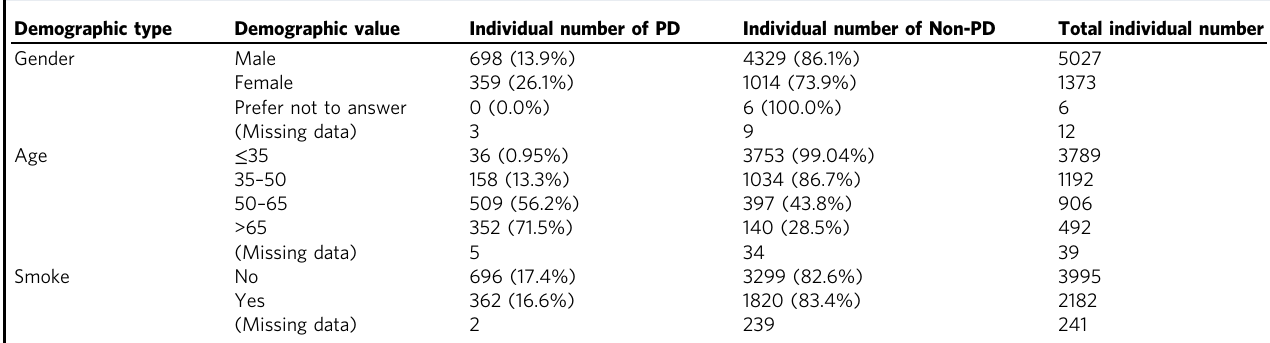
Table 1 Demographics of the individuals used in the tapping